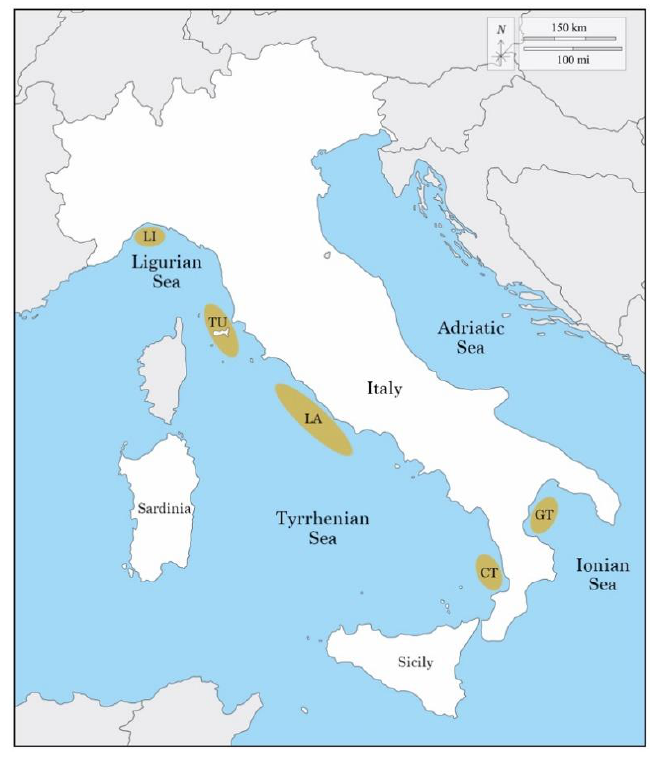
Figure 1. Locations of the sampling areas (LI: Liguria; TU: Tuscany; LA: Latium; CT: Calabria; GT: Gulf of Taranto). Details of the sampling sites are reported in Table 1. Table 1. Summary of the regional location, longitude, latitude, date, number of individuals and depth for sampling sites.